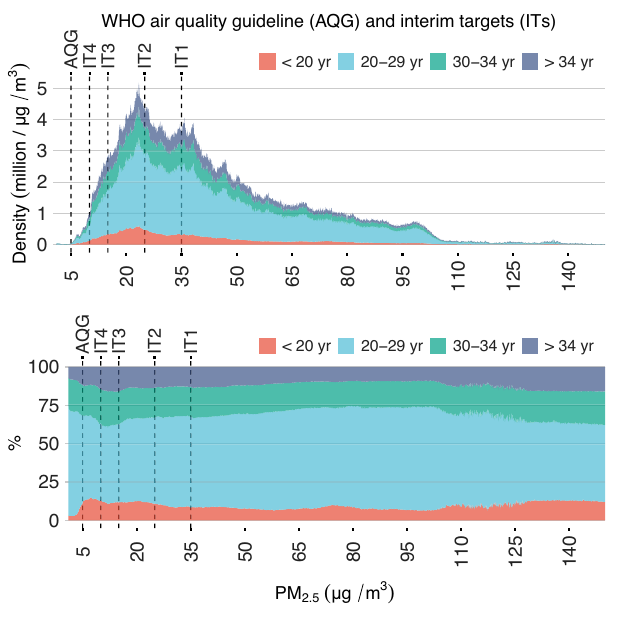
(Fig. 4). In terms of point-estimates, the health bene fi t from achieving